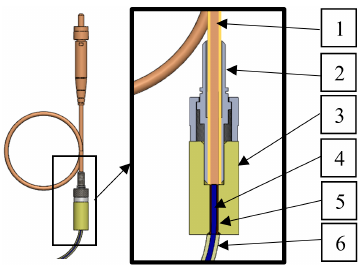
Figure 3. The connection of the fibre bundle in the cord-end terminal with the optical fibre in the standard subminiature assembly (SMA) connector (1: polymer optical fibre; 2: SMA connector; 3: the unique connector we developed; 4: reinforcing fibre bundle; 5: uninsulated cord-end